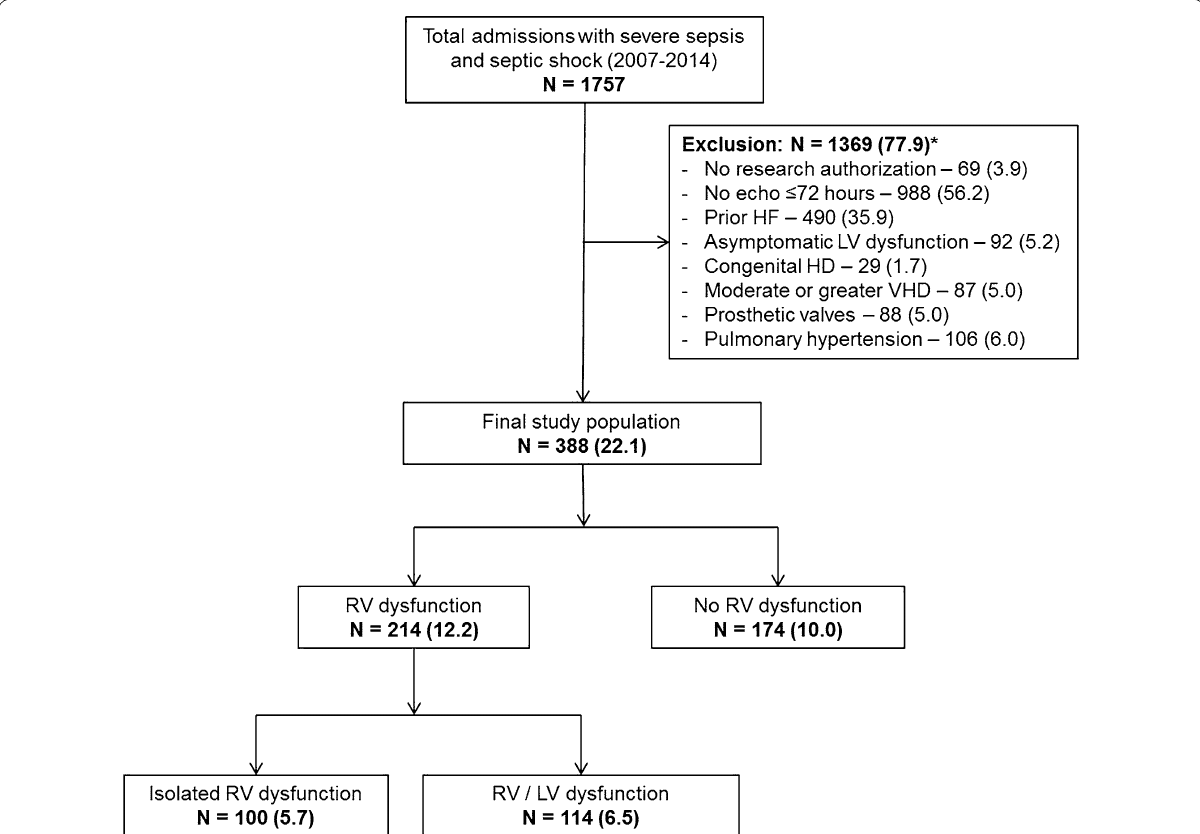
Fig. 1 Study population. *Individual percentages are not additive due to multiplicity of exclusion criteria. Represented as : number (percentage). Abbreviations : HD heart disease, HF heart failure, LV left ventricular, RV, right ventricular, VHD valvular heart